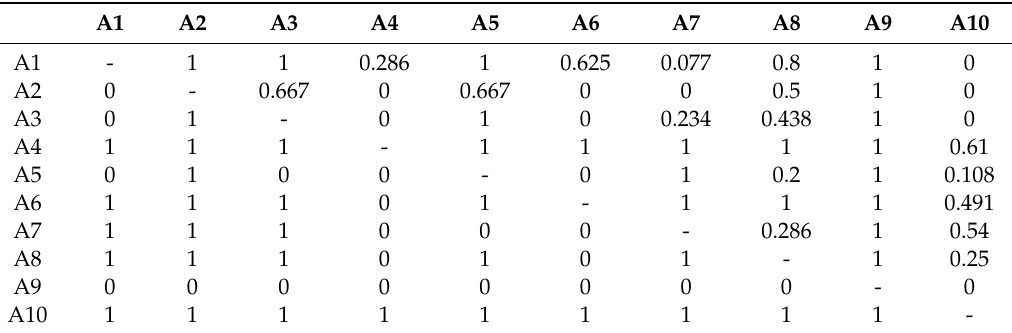
Table 23. The disconcordance matrix.